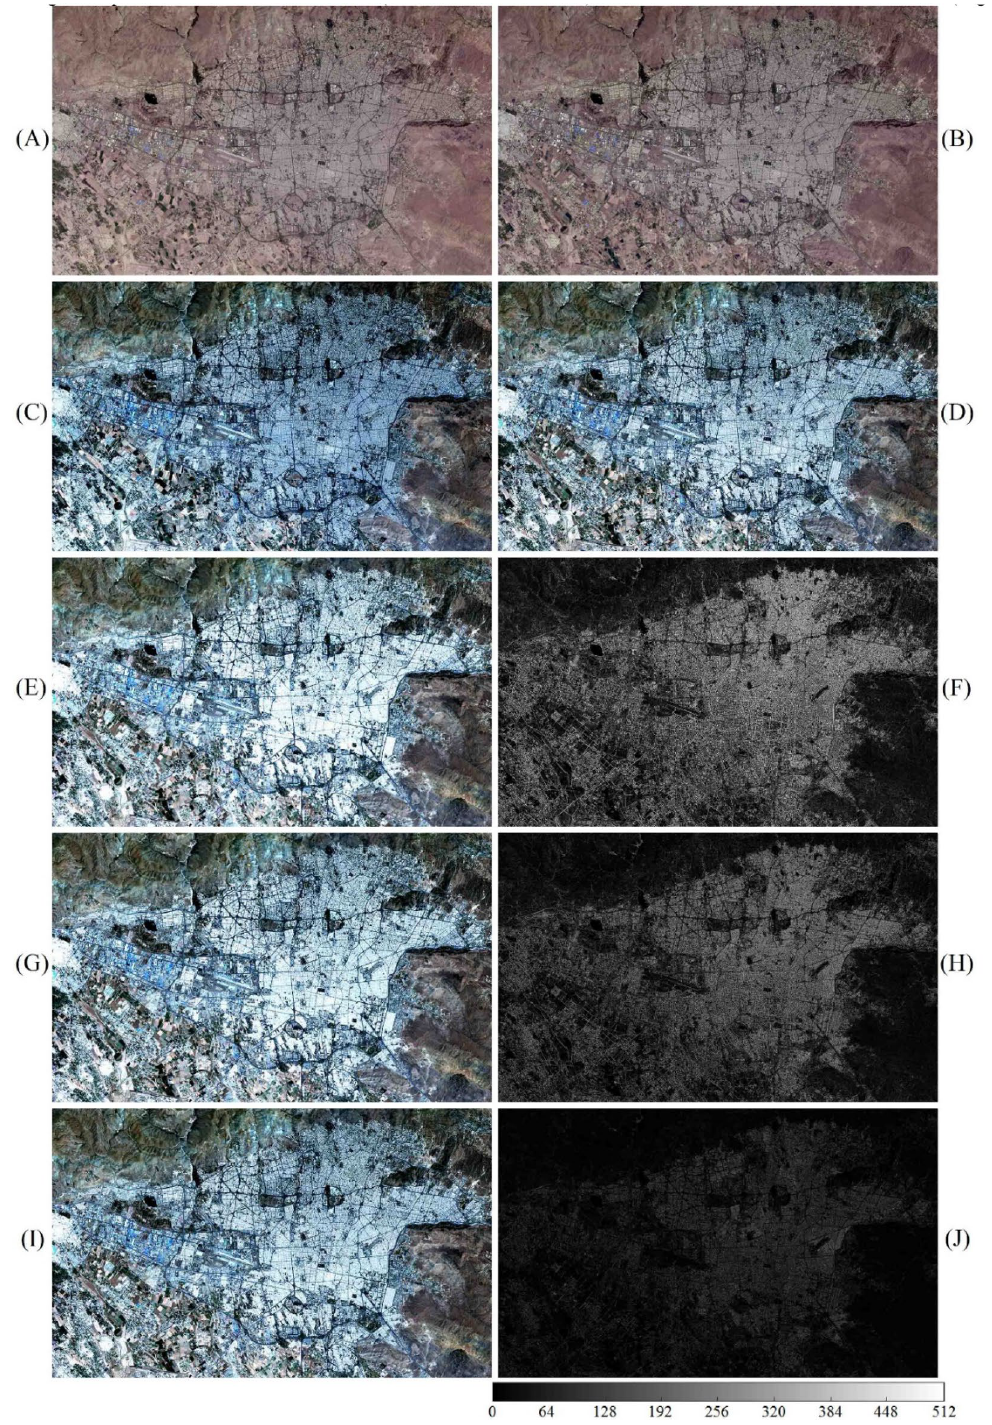
Figure 3. True color input images acquired from Tehran Province; ( A , B ) Upsampled OLI 1 and OLI 2 , ( C , D ) corresponding MSI 1 and MSI 2 , ( E , G , I ) predicted MSI 2 using Fit-FC, FSDAF, and STSR approach, and ( F , H , J ) intensity difference map between predicted MSI 2 and real MSI 2 . Scale bar shows the difference between predicted and real MSI 2 on a 12-bit